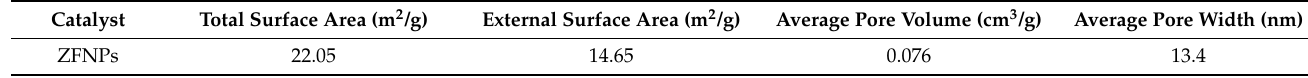
Table 1. BET surface area and porosity